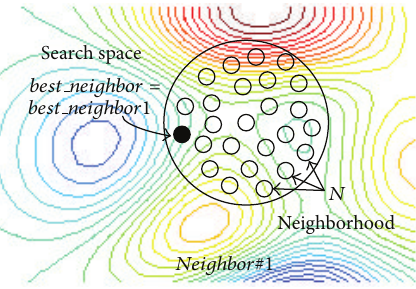
Figure 16: Assign a new best